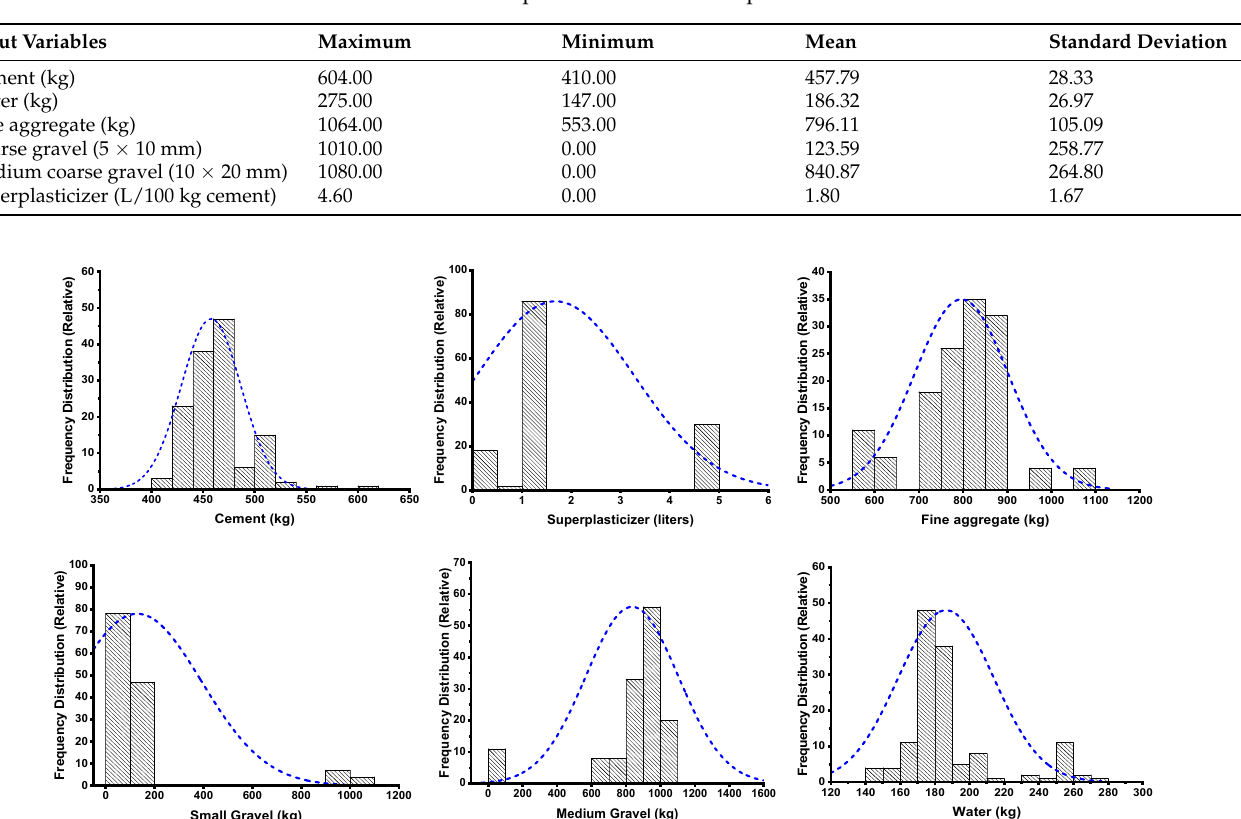
Table 1. Statistical description of the concrete’s parameters data set.